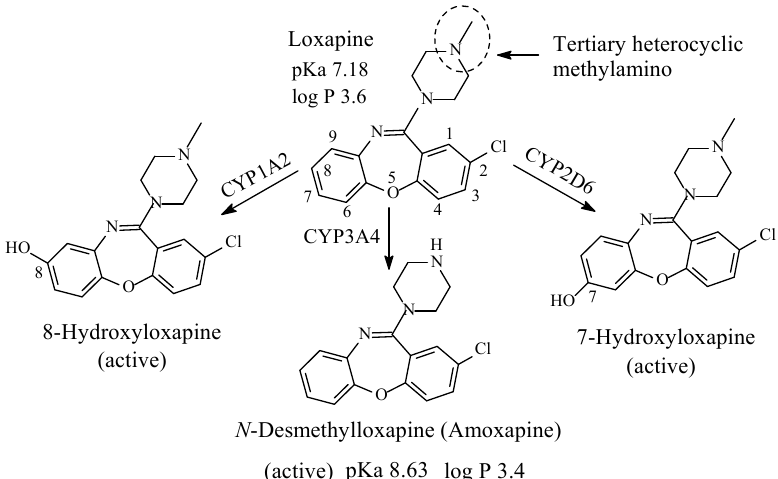
Figure 14. Metabolic pathways of loxapine.